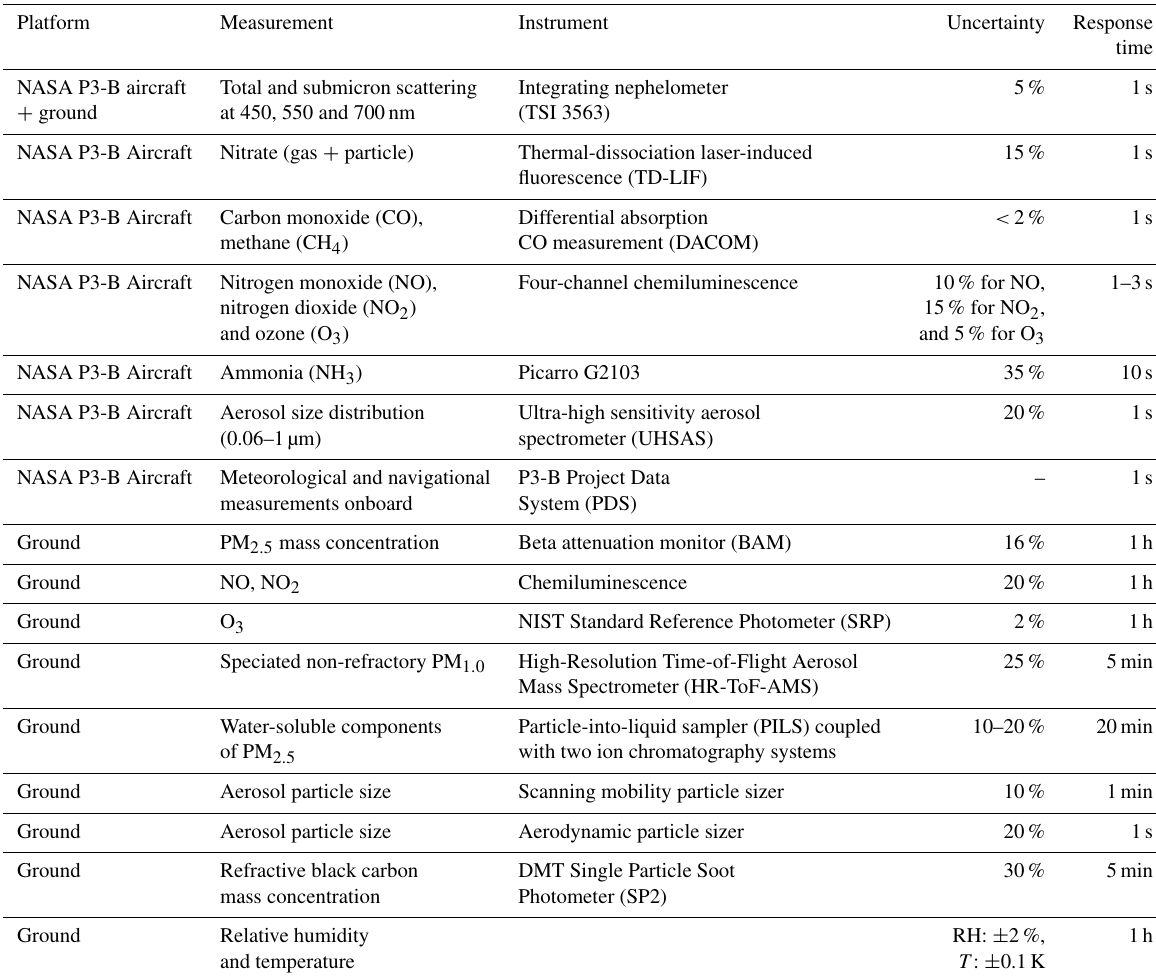
Table A1. Summary of instruments deployed and measurements on ground and on aircraft made during the DISCOVER-AQ campaign.